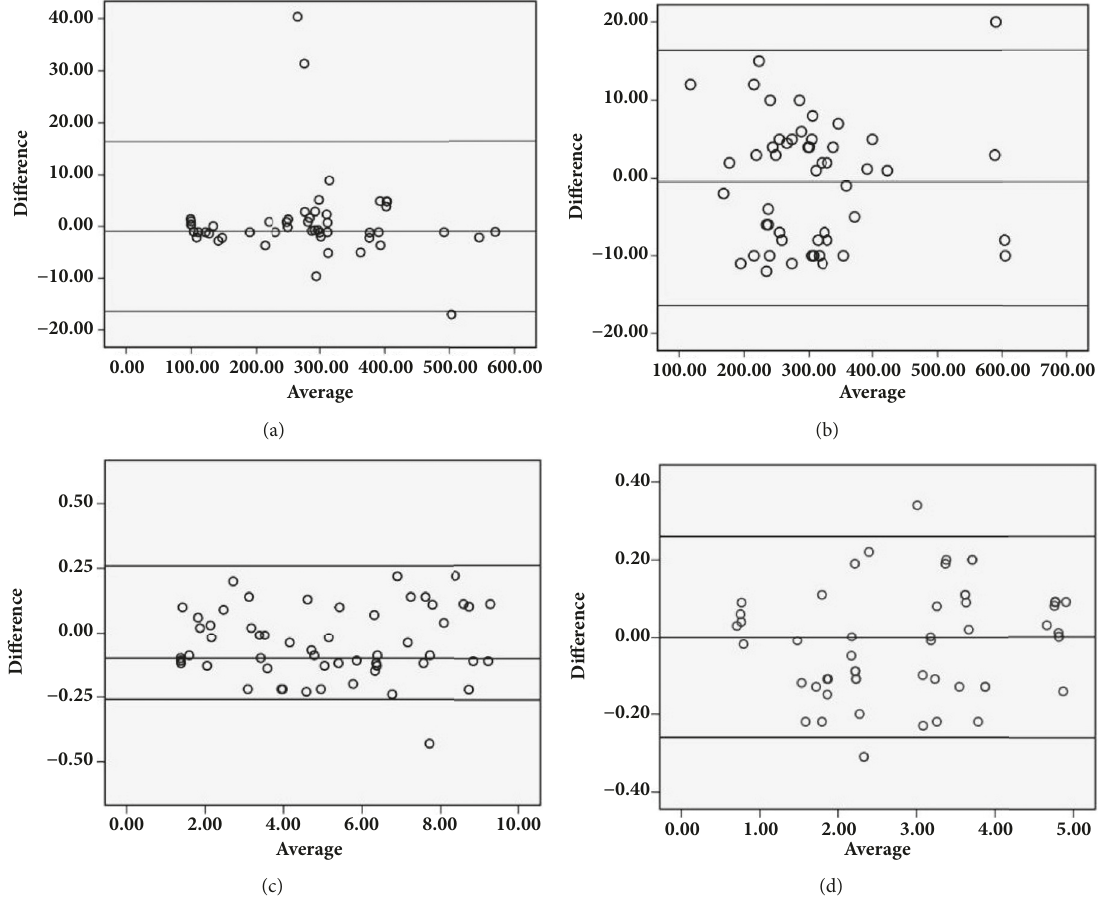
Figure4:Bland-AltmananalysisofthedevelopedHILIC-MSmethodwithliteraturereportedLC-MSmethodforhealthyandmatrixmatched spiked samples. (a) Healthy: 𝛼 -amino adipic semialdehyde/piperidine-6-carboxylic acid. (b) Healthy: pipecolic acid. (c) Matrix matched spiked: 𝛼 -amino adipic semialdehyde/piperidine-6-carboxylic acid. (d) Matrix matched spiked: pipecolic